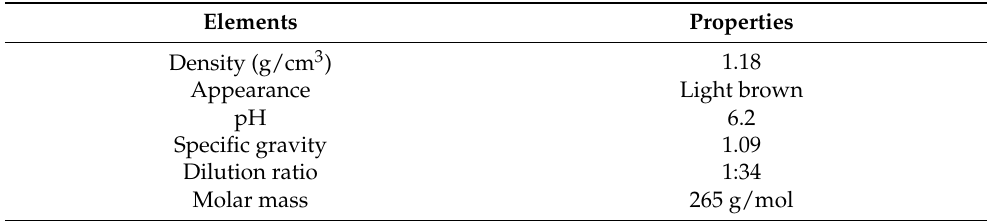
Table 2. Properties of synthetic-based surfactant.